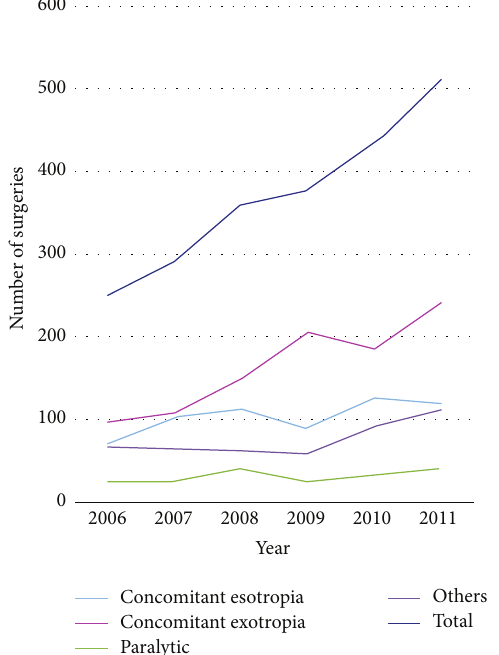
Figure 1: Amounts of the strabismus surgery between 2006 and 2011.